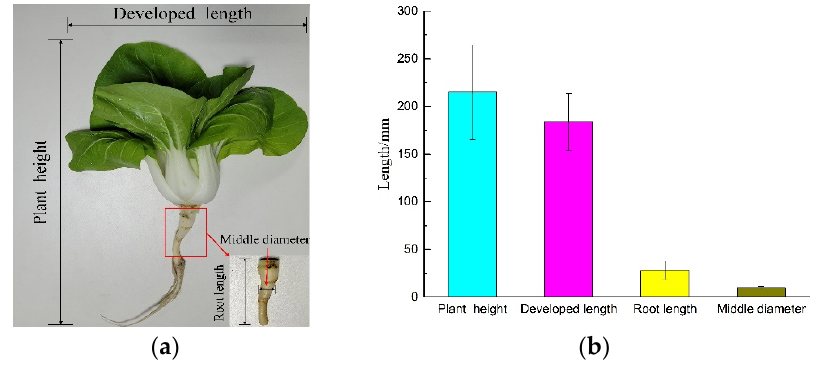
Figure 1. Test sample preparation. ( a ) Test sample. ( b ) Size parameters of little cabbage.